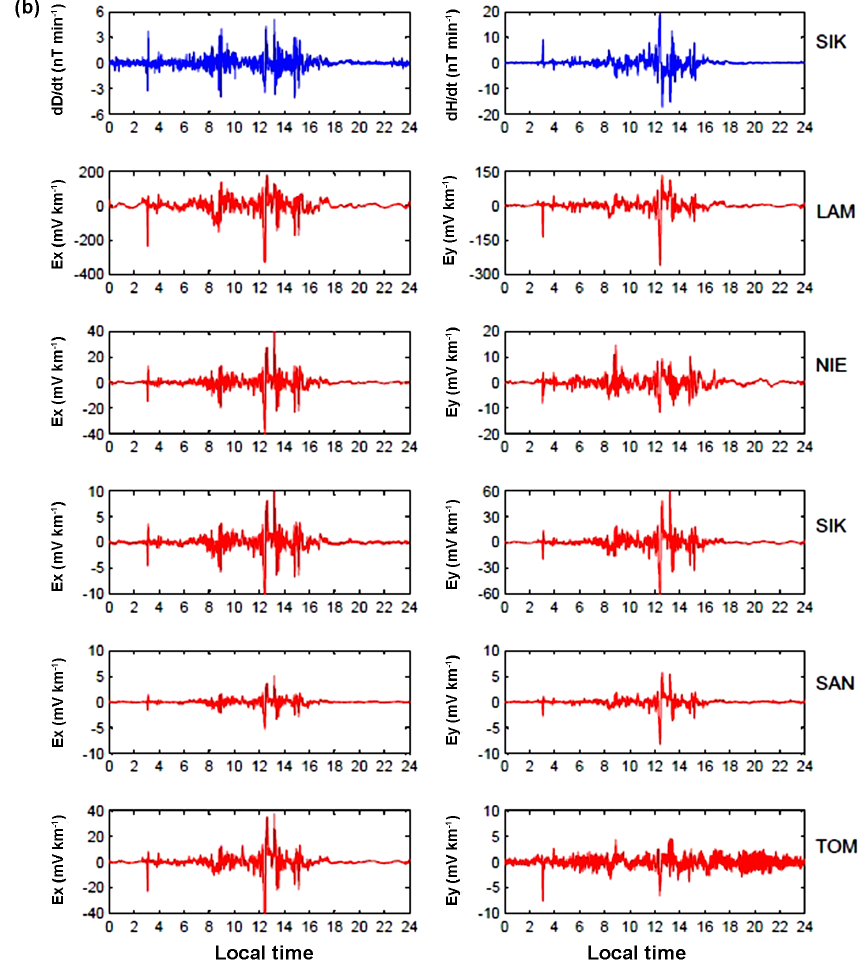
Figure 7. (a) Geo-electric field variations on 17 February 1993. The top panels show the time derivatives of H (left) and D (right) and the other panels show variations in the E x (left column) and E y (right column) at LAM, NIE, SIK, SAN and TOM. The geomagnetic field disturbance effects are superimposed on the daily regular variation in E x and E y during the geomagnetic storm. (b) Same as Fig. 7a, with the daily variations removed from E x and E y